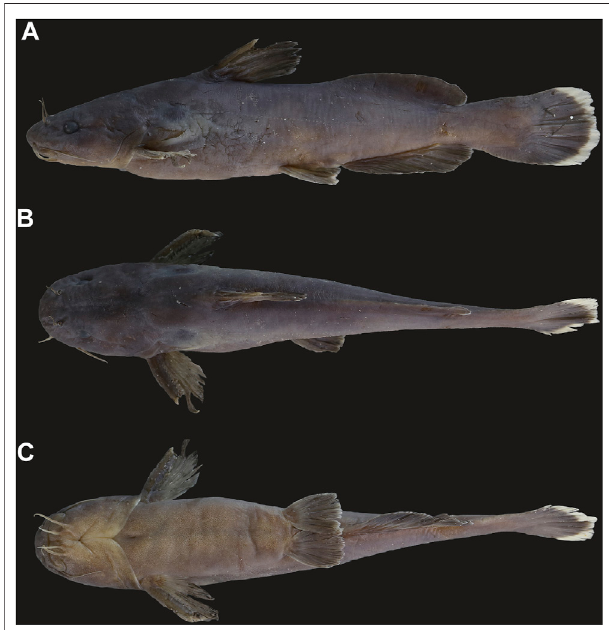
FIGURE 9 | (A) Lateral (B) dorsal and (C) ventral view of T. zhangfei in freshly captured specimen of 128.0 mm SL, from Tongren city, Guizhou